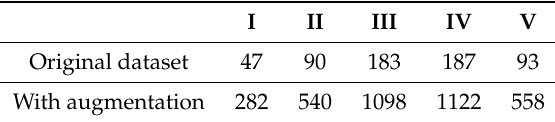
Table 1. Amount of polyps per